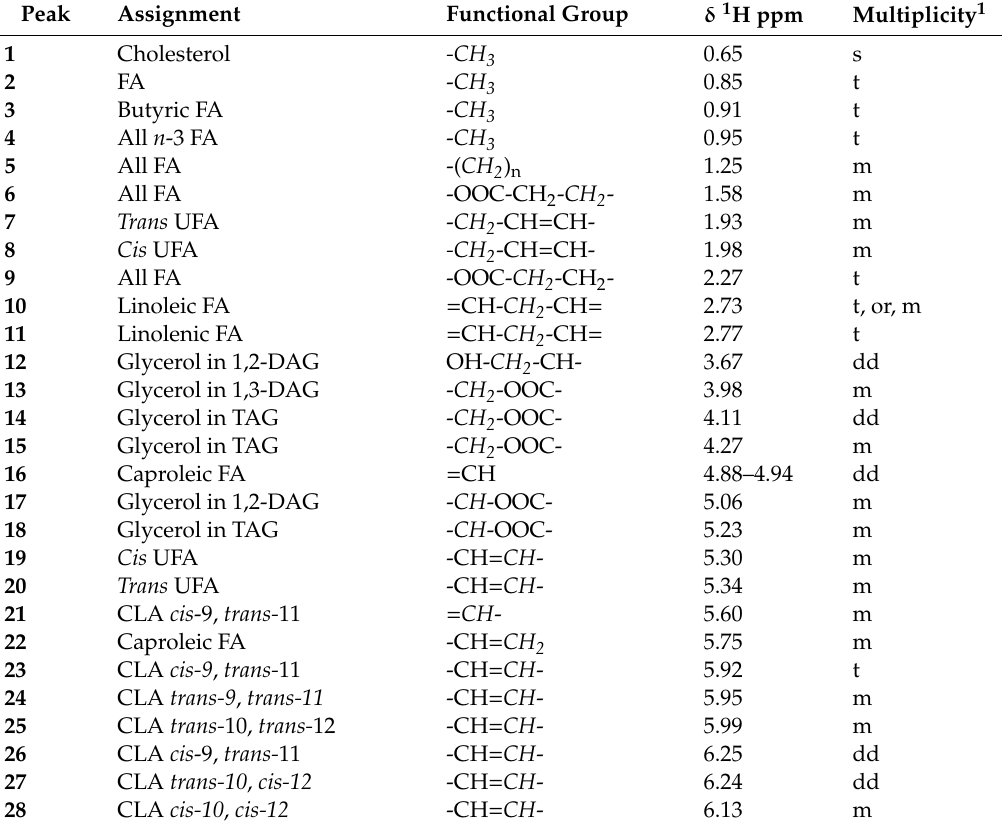
Table 1. Peak assignments for 1 H spectrum of goat milk lipid fraction, recorded on a 600 MHz spectrometer, in CDCl 3 at 298